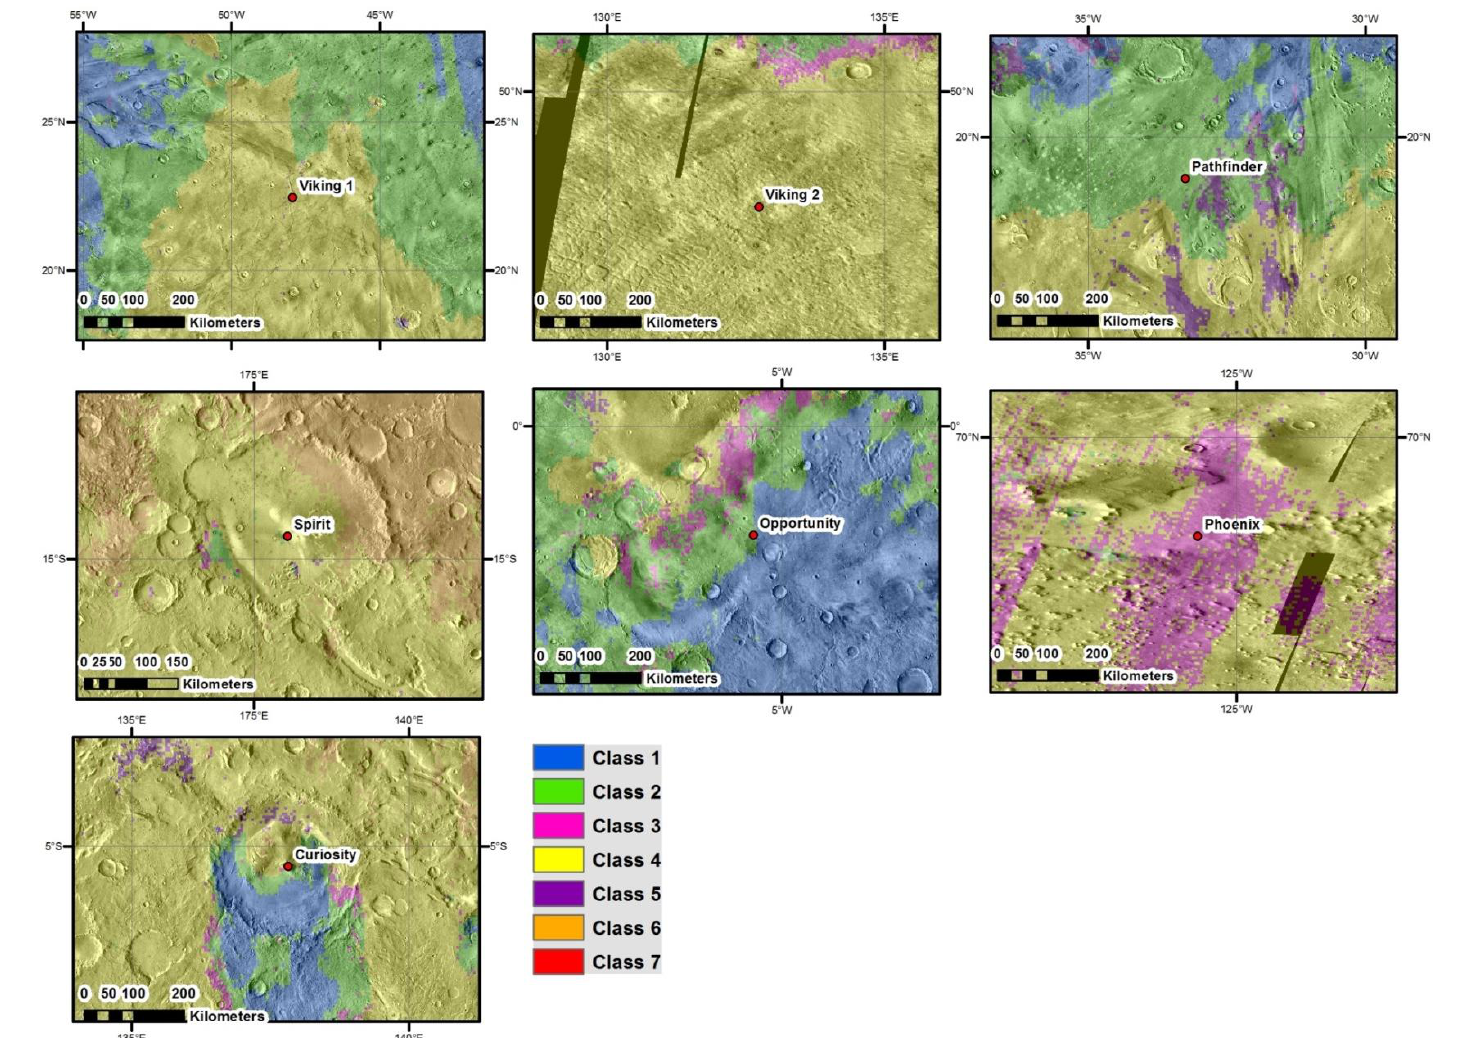
Figure 16. Classification of the seven Martian landing sites in the thermophysical map of Figure 13, overlaid on the THEMIS Daytime-IR basemap. Image credit: NASA Mars